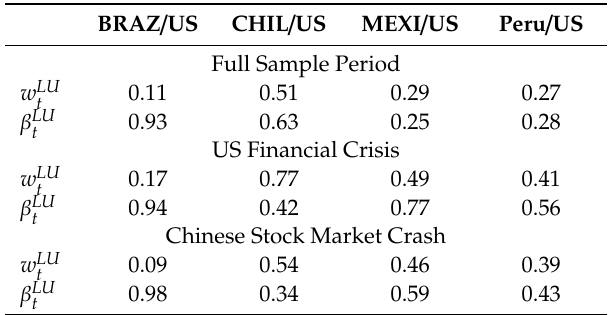
Table 9. Optimal weights and hedge ratios for Latin America (LA) / US BRAZ / US CHIL / US MEXI / US Peru / US Full Sample Period w LU t